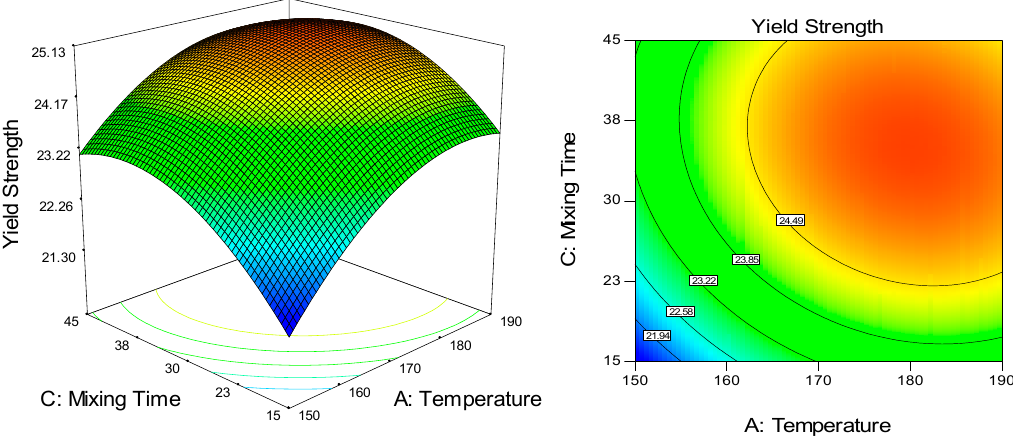
Figure 5. The 3D and contour plot for the dependence of UHMWPE / CNF bionanocomposite’s yield strength on temperature and mixing time as significant factors.